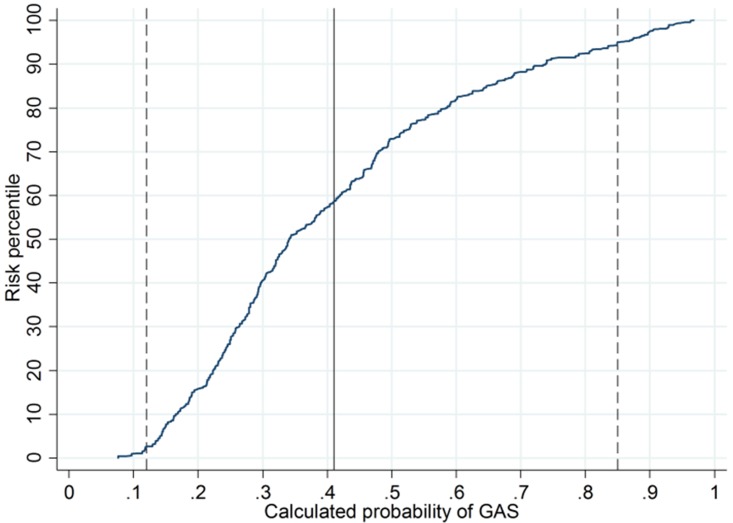
Distribution of calculated probabilities of group A streptococcus (GAS) when applying the clinical prediction model.The vertical dashed lines represent thresholds used to define low and high probability of GAS (calculated probability of GAS<0.12 and >0.85, respectively). The vertical black line represents disease prevalence (0.41).